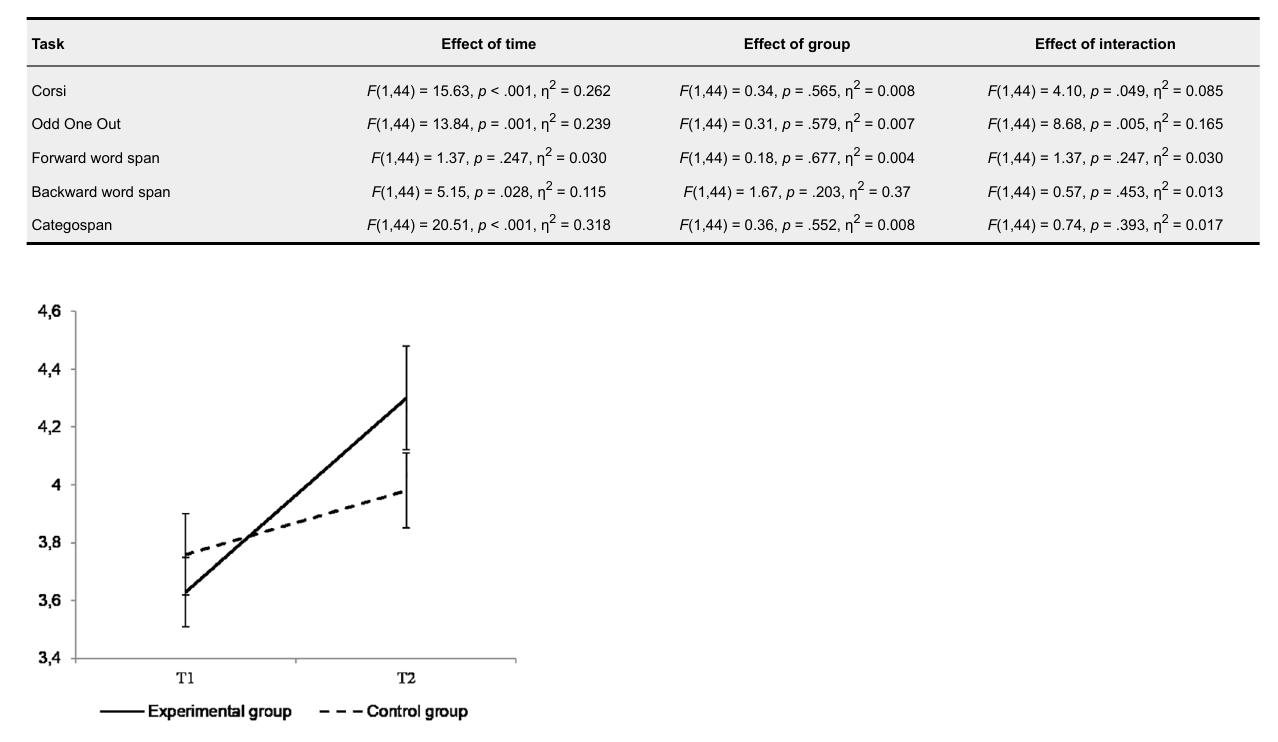
Figure 3. Interaction between time (T1 and T2) and group (Experimental and Control) for the span measure in the Corsi task. Error bars represent standard errors.